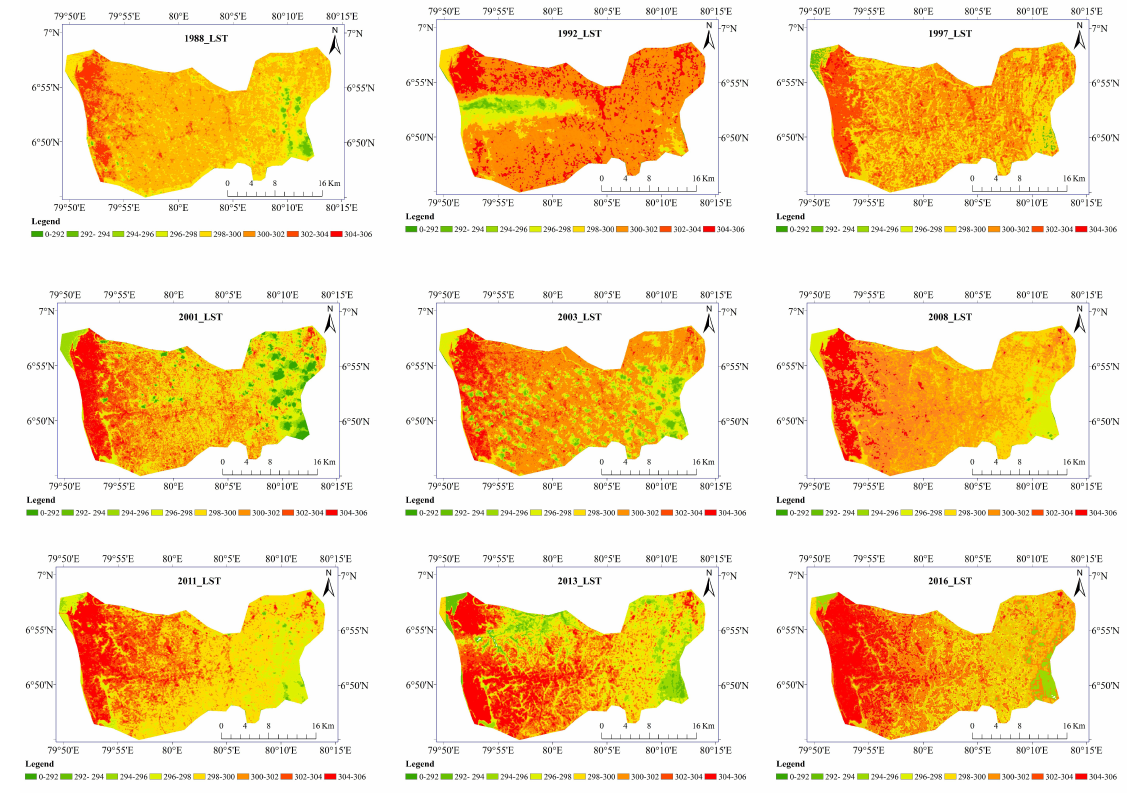
Figure 6. Annual Land Surface Temperature for corresponding years to land cover classification.